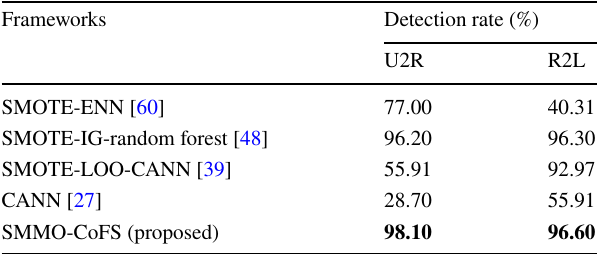
Table 12 Performance comparison of the proposed framework with other NIDS frameworks in terms of accuracy and F -measure